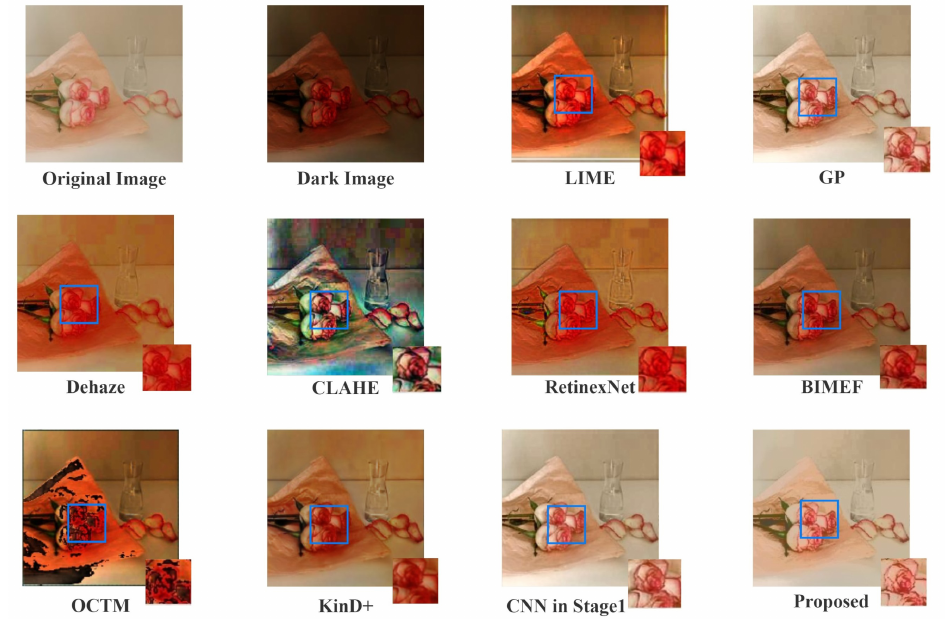
Figure 6. Example of low-light enhancement on a synthesized low-light